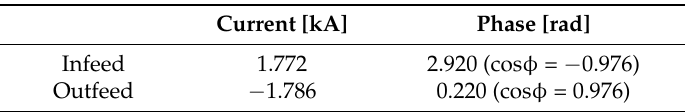
Table 2. Node 8 current module/phase measurements.